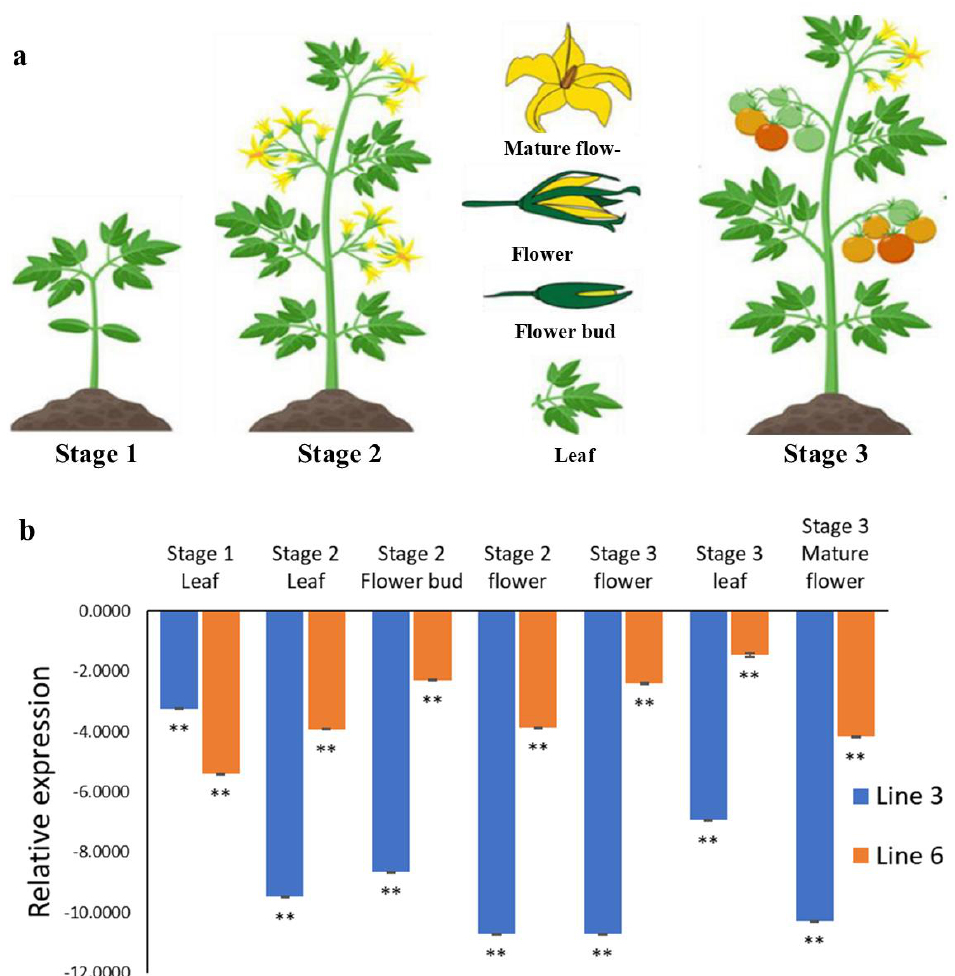
Figure 6. Relative gene expression between WT and genome-edited lines at different stages. ( a ) Ex- plants and their stages used for qRT-PCR analysis. ( b ) Relative expression analysis of SlACO2 knockout and WT plants by qRT-PCR at different developmental stages of leaf and flower tissues (the Actin gene was used as an internal reference gene). Data provided represents fold expression Log2 (WT/genome-edited lines). Values represent the average ± SD of three biological replicates of each reaction. ** indicate significant differences at p < 0.01.